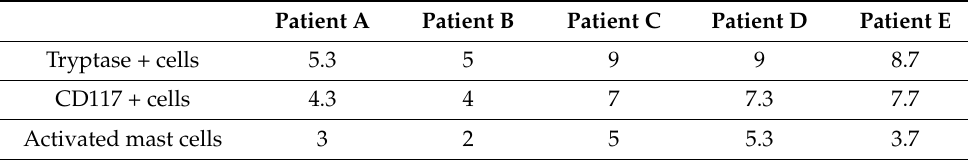
Table 2. The number of mast cells in each histochemical section.